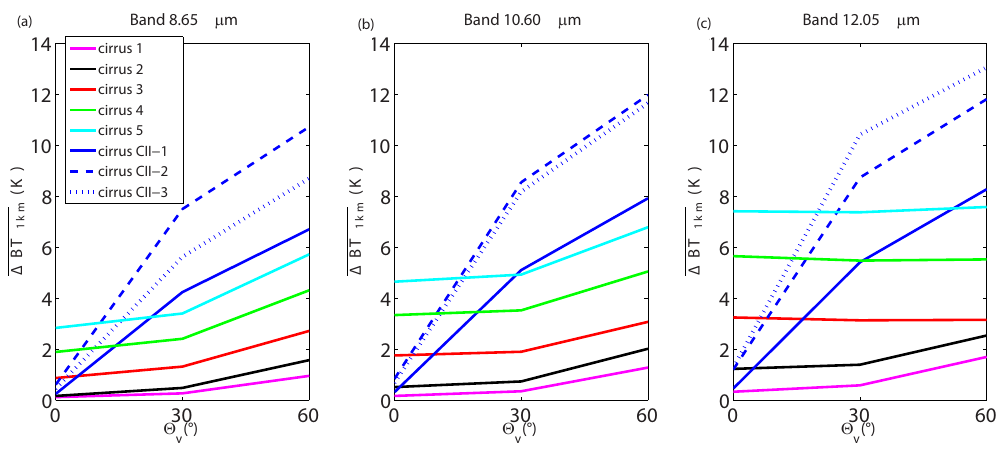
Figure 17. Mean difference 1 BT 1km as a function of the zenith view angle 2 v ( ◦ ) for cirrus 1 to 5 and cirrus CII-1 & CII-2 for the bands at 8 . 65µm, 10 . 60µm and 12 .